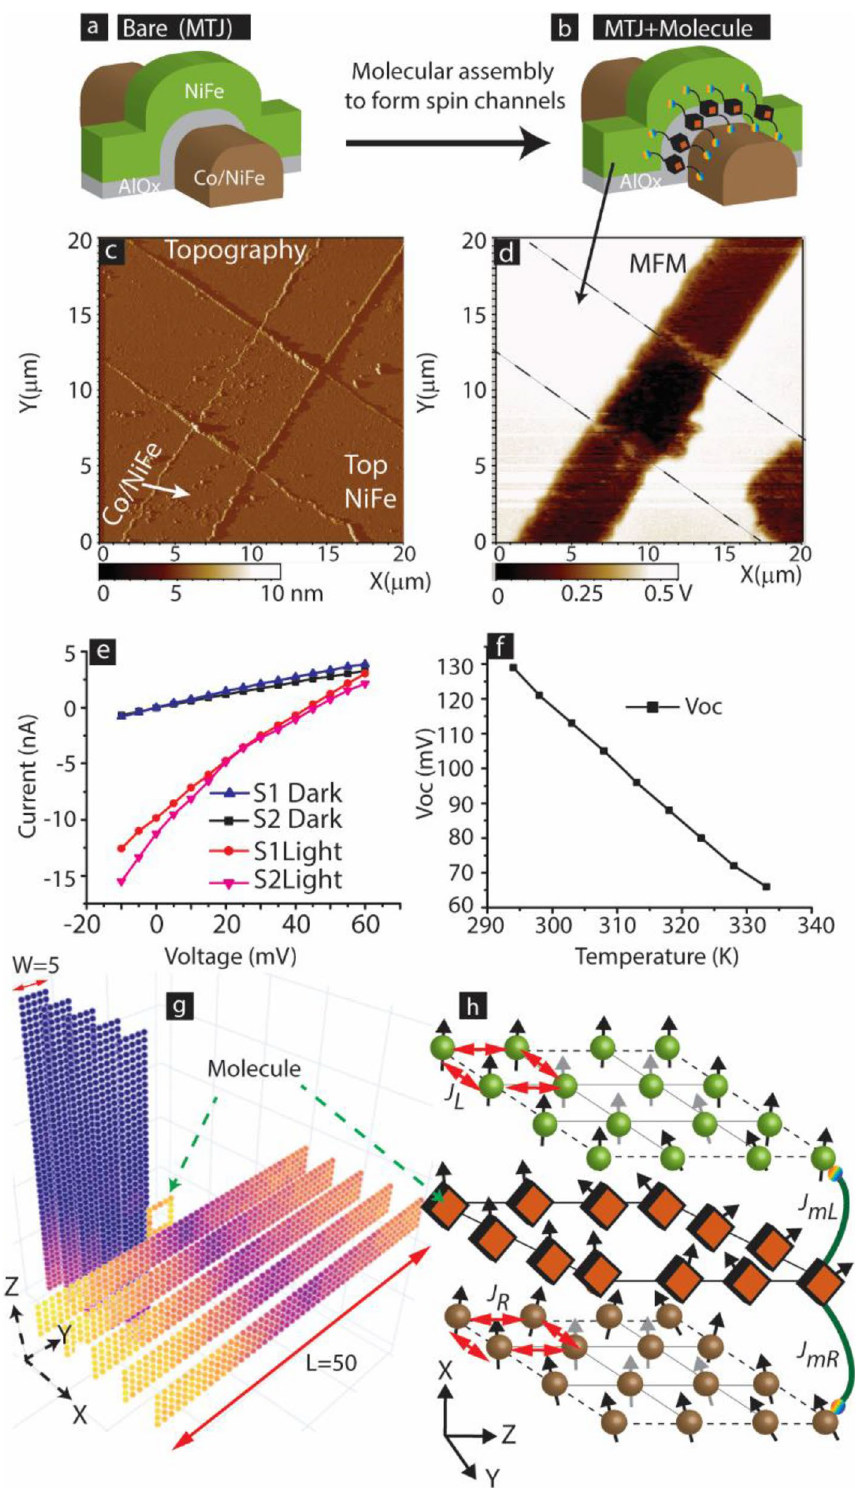
Figure 1. 3D illustration of cross-junction shaped MTJ with exposed side edges ( a ) before and ( b ) after connecting paramagnetic molecules between ferromagnets. ( c ) AFM topography image of microscopic MTJMSD ( d ) showing the formation of strip on one magnetic electrode in MFM study. Dashed line are guides to eye for indicating impacted top NiFe region. Black color represents the higher end of the MTJMSD induced magnetic field, yielding a force on the MFM tip. On the other hand, the white color represents the lower bound of the magnetic force experienced by the MFM tip. MTJMSD showing ( e ) spin-photovoltaic effect in I–V study, and ( f ) temperature dependent open circuit voltage. ( g ) 3D atomic model of 5 × 5 molecular device analogous to conceptual MTJMSD illustration shown in panel ( b ). ( h ) Description of coupling energy around 4 × 4 molecular junction of 3D model shown in ( g ). ( g ) Is only for illustration purpose and include fewer molecules and interfacial FM atoms to present uncluttered view of exchange